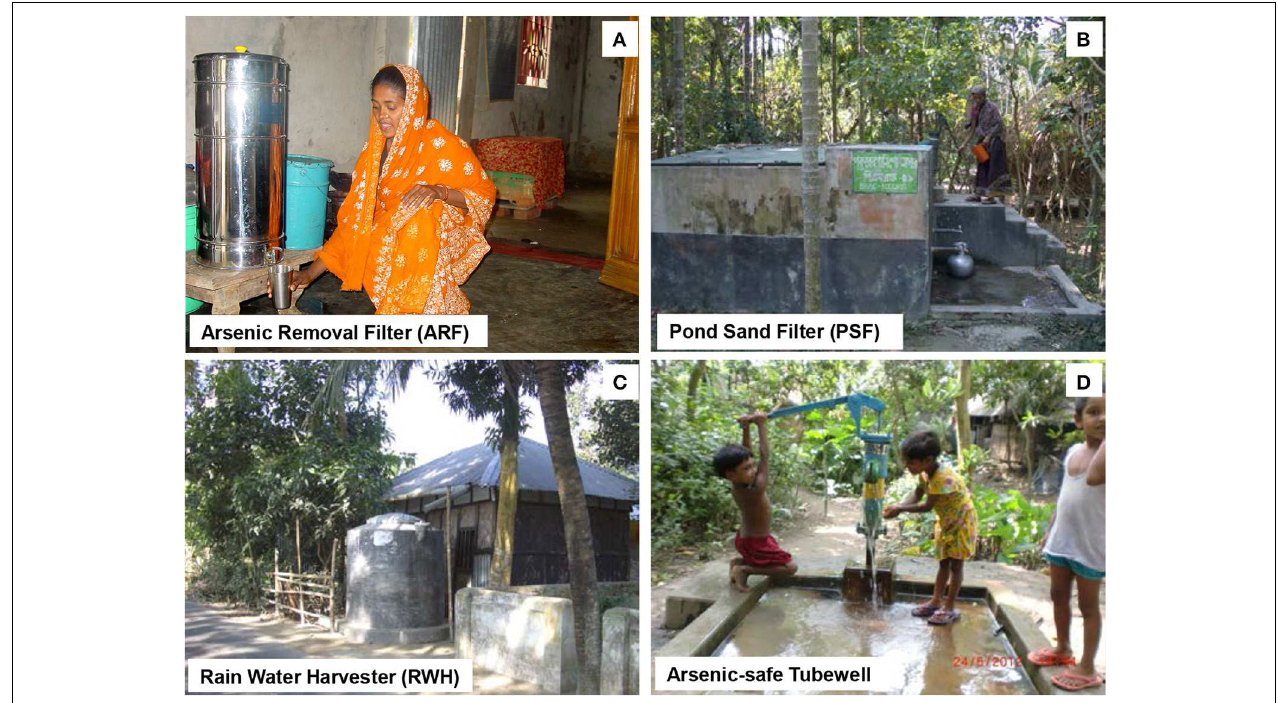
FIGURE 2 | Different options of As-safe drinking water (A) Arsenic Removal Filter (B) Pond sand Filter (C) Rain Water Harvester (D) As-safe Tubewell.